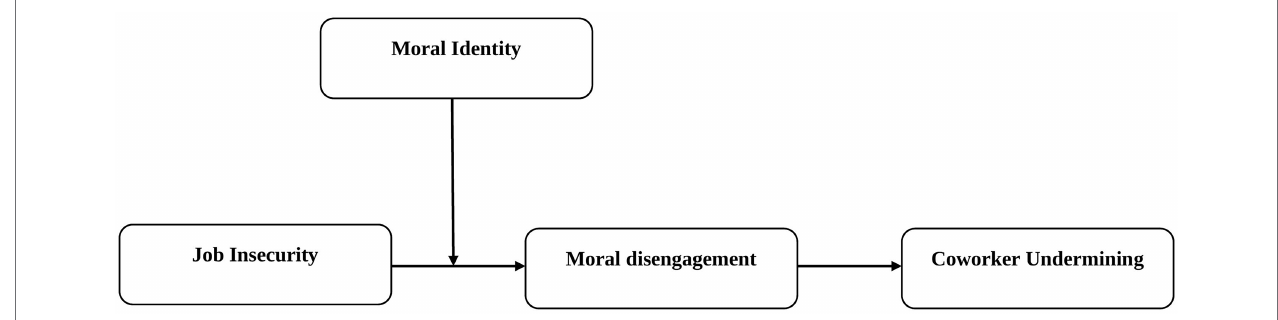
FIGURE 1 | The proposal moderated-mediation